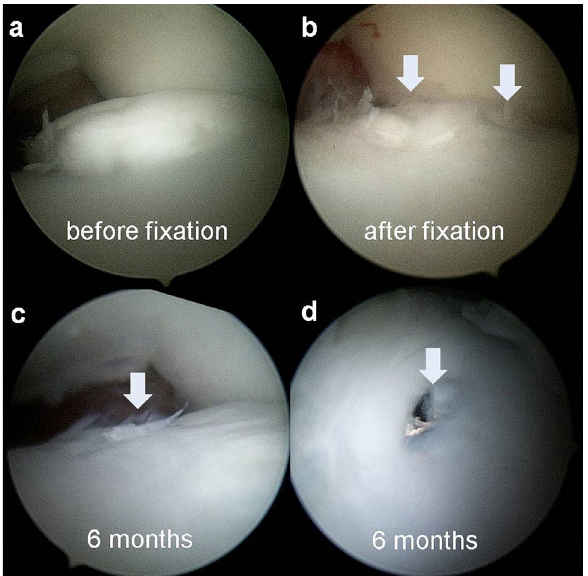
look arthroscopic procedure was performed 6 months after the internal fixation, during the metal screw removal surgery. The osteochondral fragment was congruent with the surrounding cartilage. Smooth hyaline-like cartilage was observed. ( d ) The metal screws were located for removal. The arrows show where the metal screws were